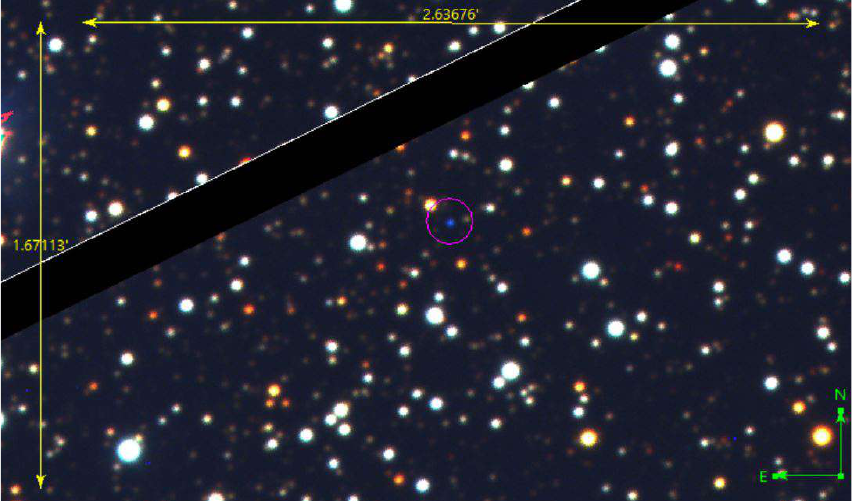
Figure 5. A 3 color composite RGB (U:blue, B:green, V:red) FORS2 acquisition image centered on the suspected faint, blue central star, which is clearly seen as the only blue star of hundreds in the field (and circled in purple) and is located very close to he geometric centre of the PN itself. The angled black band is the